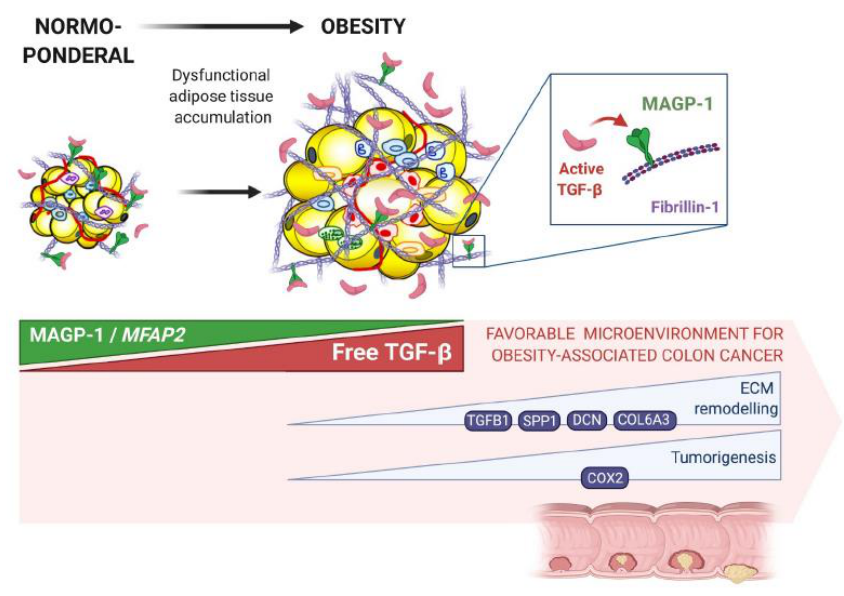
Figure 5. Proposed mechanism of the involvement of MAGP-1 in obesity-associated CC development. Decreased MFAP2 gene expression levels in the visceral adipose tissue from patients with obesity and colon cancer may be responsible for the increased free active TGF- β enhancing its downstream signalling pathways associated with inflammation, ECM remodelling and tumorigenesis. Therefore, MAGP-1 may participate in creating a favourable microenvironment to tumorigenesis in obesity and, thus, function as a link between adipose tissue excess and obesity-associated CC development.